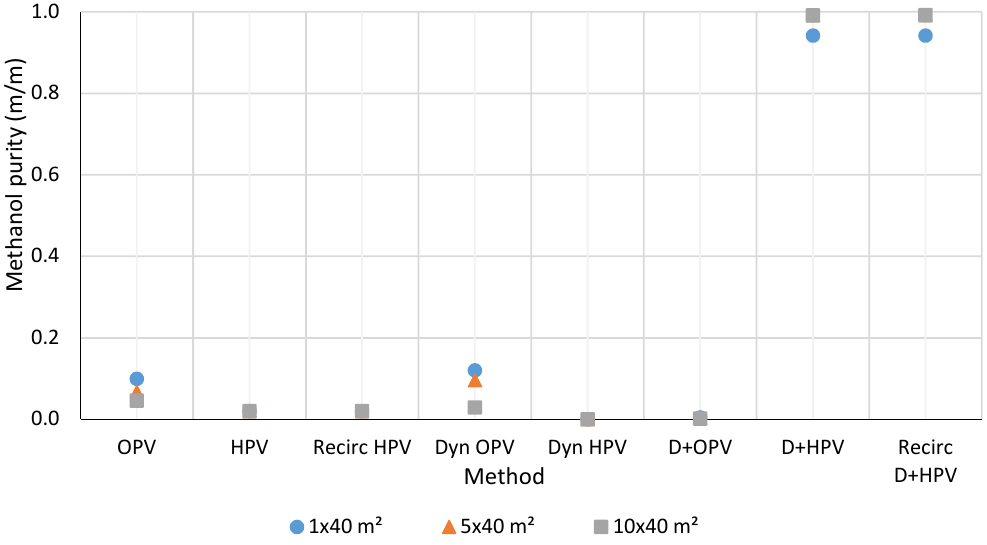
Membranes 2020 , 10 , x FOR PEER REVIEW Figure 12. Comparison of the ethanol purity of ethanol-water purification methods.